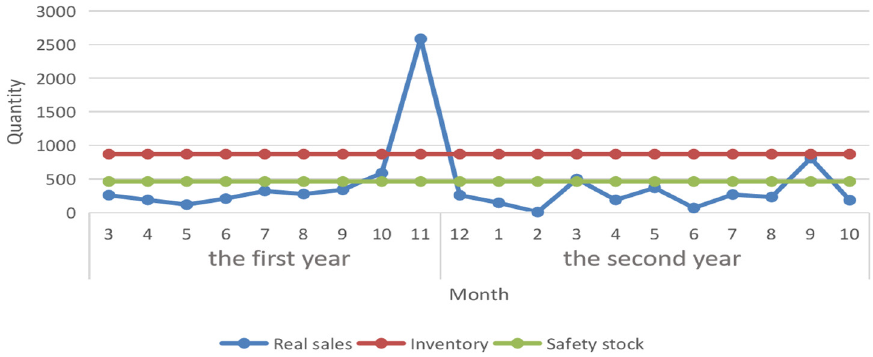
Figure 5. Safety stock statistical model results.